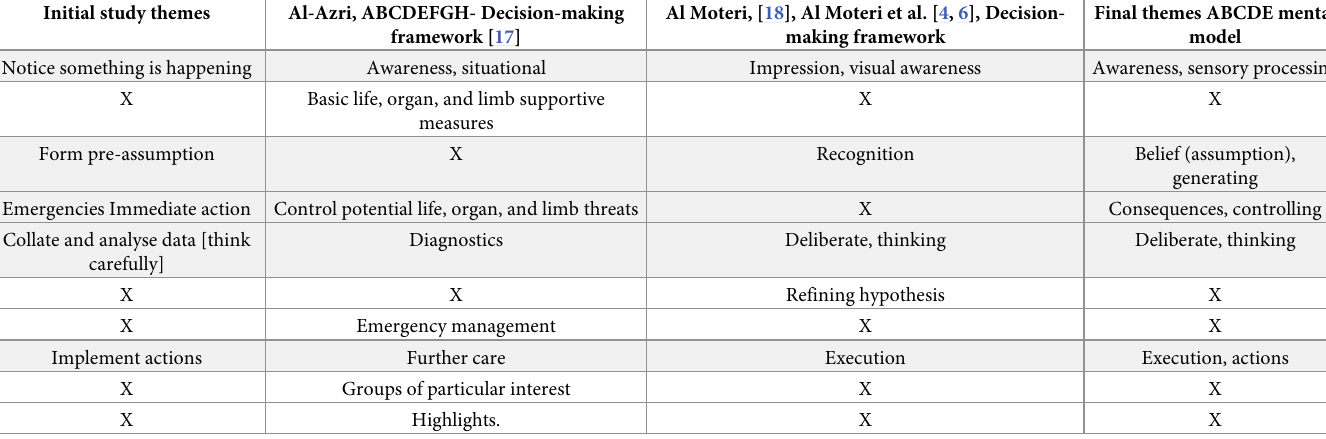
Table 1. Alignment of emerged codes and themes with existing literature during the deductive